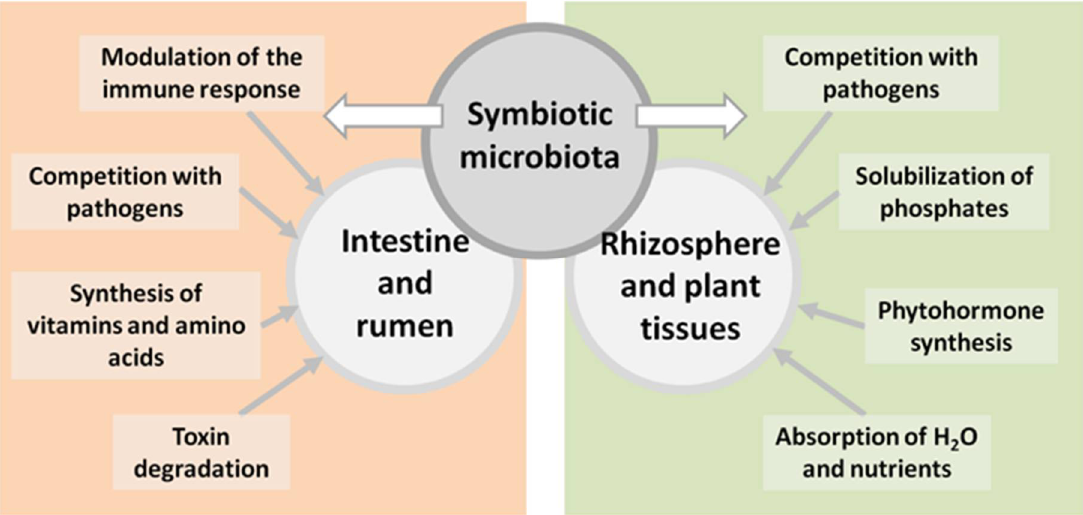
Figure 2. Functional roles played by the symbiotic microbiota in animals and plants, demonstrating the importance of the animal-microorganism and plant-microorganism relationships, which go far beyond the pathogenic role of some strains.